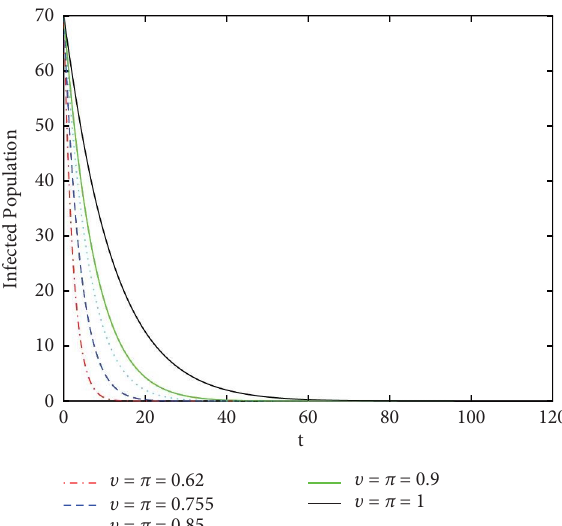
Figure 20: Te dynamics of susceptible human population for various fractal-fractional orders.